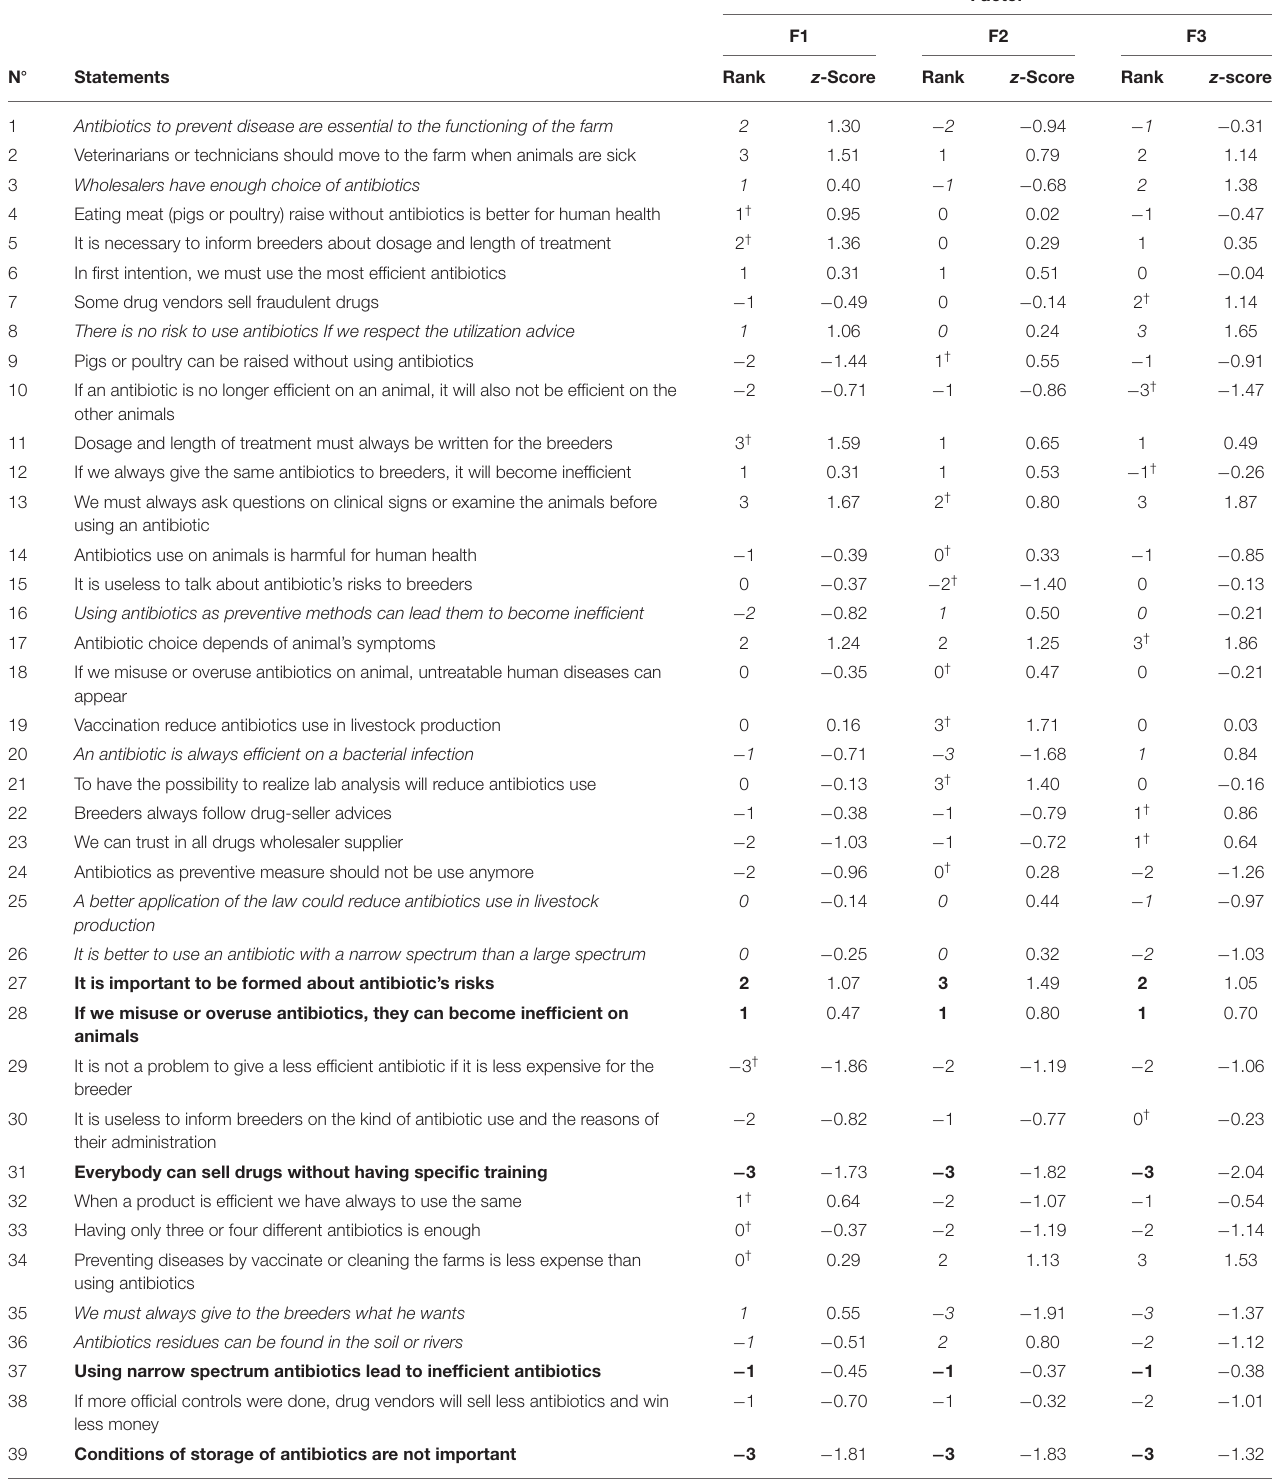
TABLE 4 | Q-set , rank and z-scores for the P-set drug